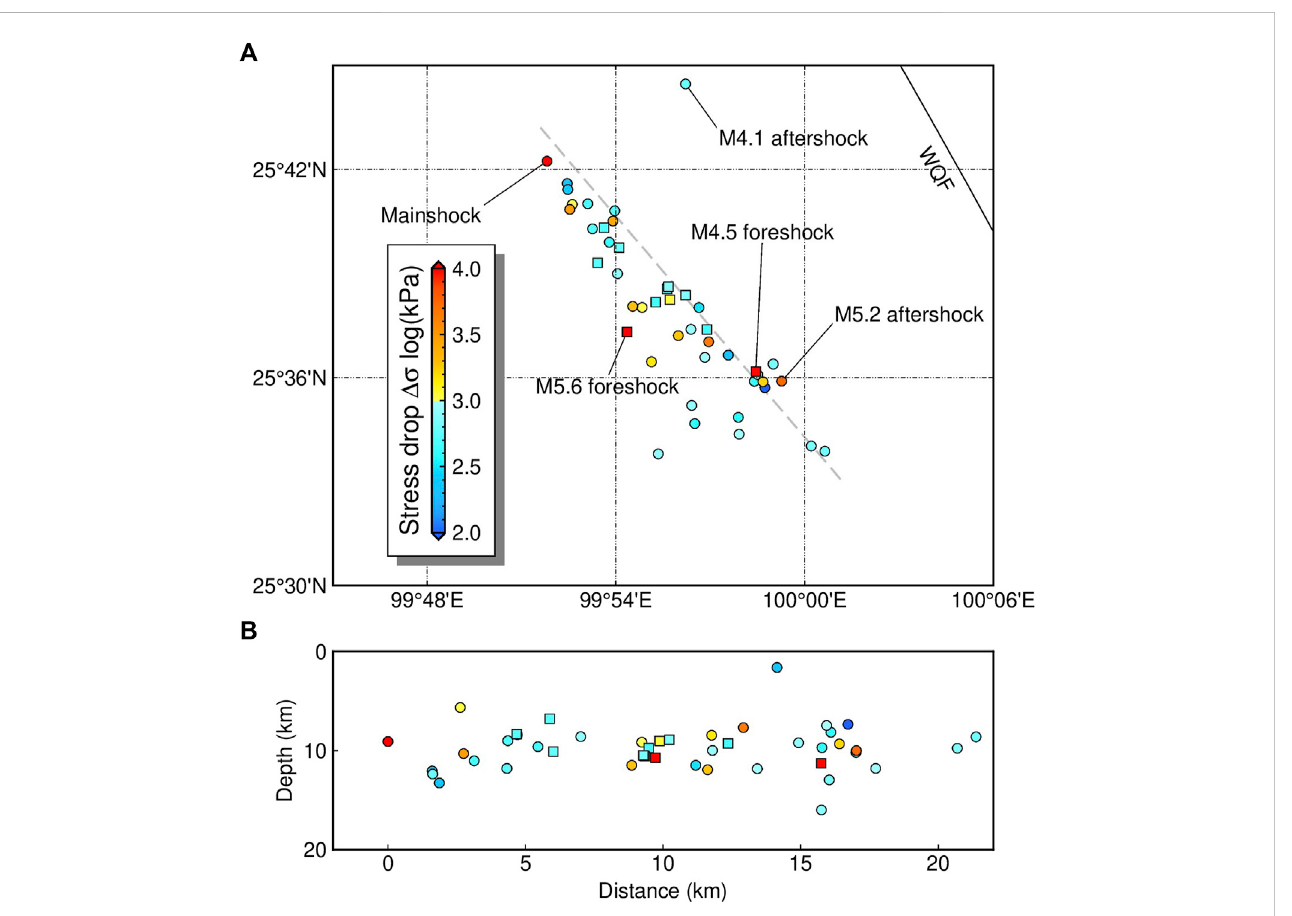
FIGURE 9 (A) Map view and (B) depth cross-section of stress drops for the 21 May 2021 Yangbi earthquake sequence. The fi lled symbols illustrate the relocated sources, with their stress drops coded by colors. The squares represent the foreshocks, and the circles represent the mainshock and aftershocks. The Weixi – Qiaohou fault (WQF) is represented by a black lines. The mainshock is located at distance=0 in the depth cross-section. Gray dashed line shows the location of the